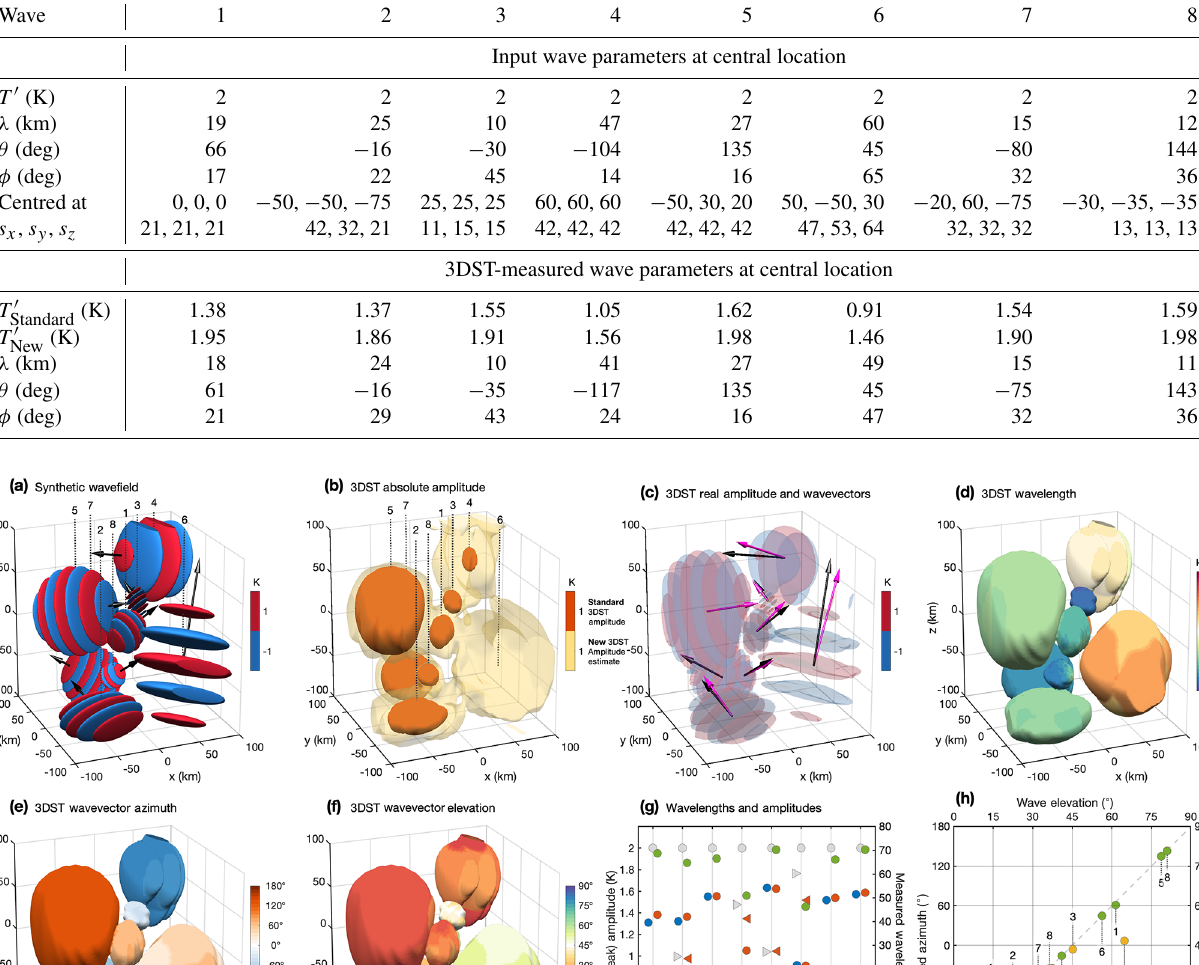
Table 1. Input and measured synthetic wave parameters for the test of our 3-D Stockwell transform (3DST) method on a synthetic wavefield. The specified wave parameters are (i) wave amplitude T (cid:48) (maximum temperature perturbation); (ii) wavelength λ ; (iii) azimuth θ ; (iv) eleva- tion angle φ ; (v) the location at which the wave is centred; and the standard deviations of the Gaussian envelope for each wave packet s x , s y and s z in the x , y and z directions respectively. T (cid:48) and T (cid:48) denote the 3DST-measured wave amplitude using the “standard” method New Standard and “new” composite S-transform method described in Sect. 3.4.1.